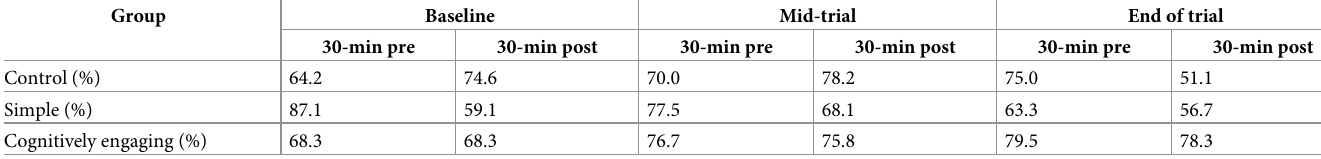
Table 5. Percentage of observations rated as on-task across the observation periods by group. Group